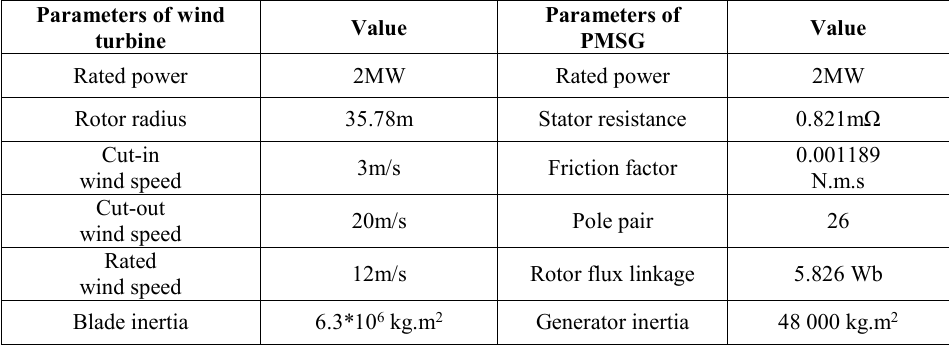
Table 1. Wind turbine simulation